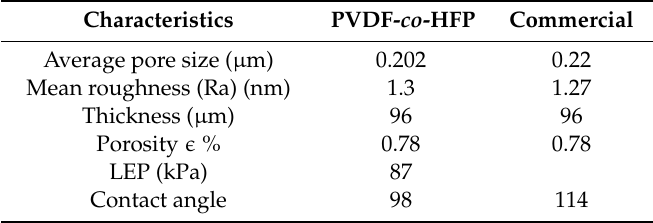
Figure 2. Surface topography (Top) and pore size distribution (Bottom) images determined by AFM for fabricated PVDF- co -HFP ( A , C ) and commercial PTFE ( B , D ) and ( E ) and ( F ) are the cross-sections and top surface SEM images of the PVDF-g-HFP membranes while ( G ) and ( H ) are the cross-sections and top surface SEM images of the commercial membranes. Table 3. Characteristics of the